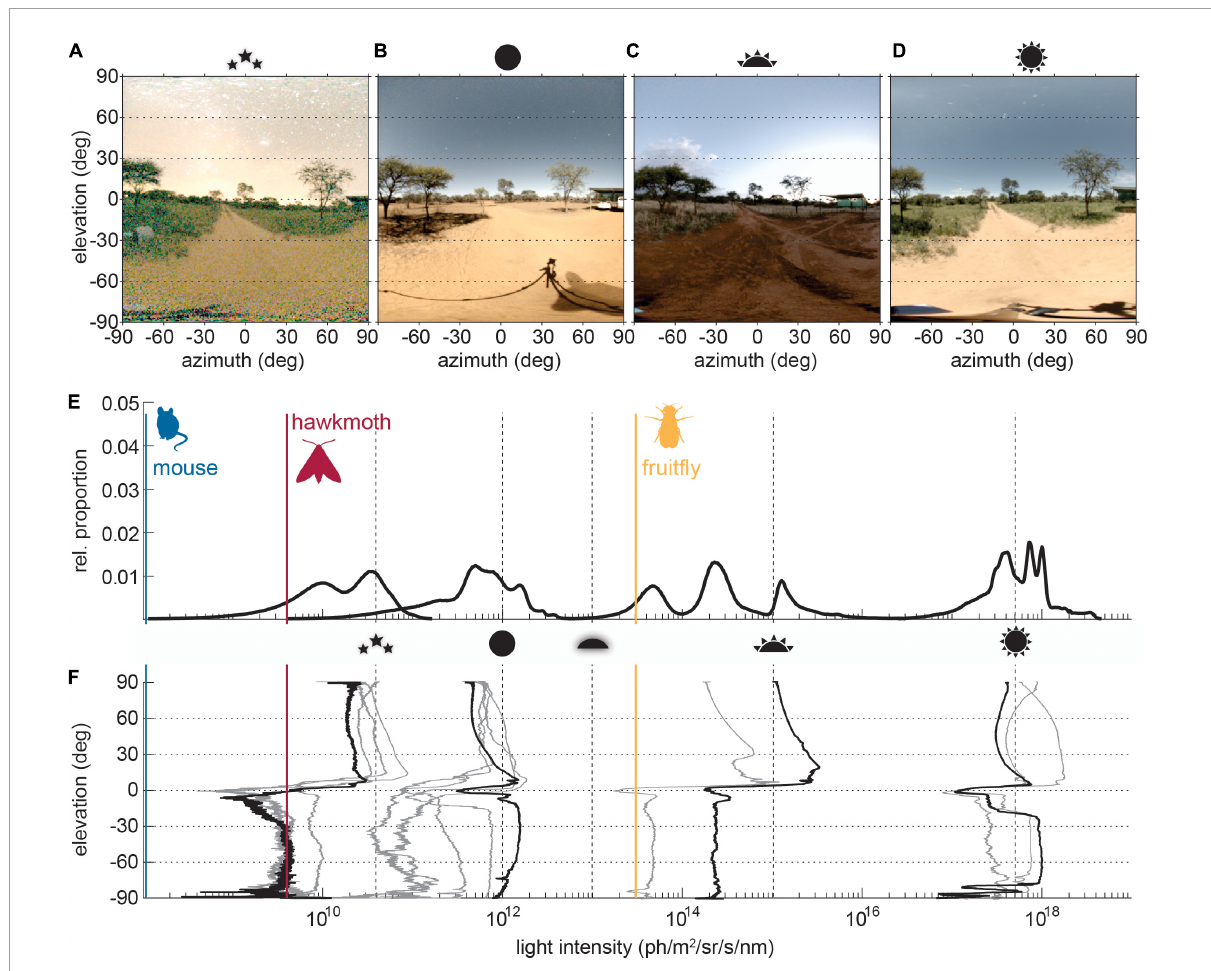
FIGURE1 Light intensity distributions in visual scenes across times of day. (A–D) The same visual scene near Vryburg (26 ◦ 23 (cid:48) 55.82 (cid:48)(cid:48) S, 24 ◦ 19 (cid:48) 37.380 (cid:48)(cid:48) E) in South Africa, photographed Southward under different celestial illumination conditions as indicated by the icons (starlight on a moonless night, full moon light with moon above 60 ◦ elevation, sunset, noon). (E) The relative proportion of pixel intensities and the (F) average pixel intensies across scene elevation. Panel (E) shows the average brightness histograms for starlight , moonlight , sunset/runrise , and sun at noon of a number of individual scenes with elevation intensity profiles depicted in gray in panel (F) . The profiles of the example scenes in panels (A–D) are highlighted in black. The dashed lines indicate average light intensities under typical celestial conditions ( max. starlight , max. moonlight , end of twilight , sunset/sunrise and max. sunlight ). The relative scaling of these were taken from Warrant (2008), while the scale was anchored in absolute terms to the intensity for sunlight from Nilsson and Smolka (2021). The visual thresholds of the three indicated model species [mouse Mus musculus (Umino et al., 2008), hawkmoth Deilephila elenor (Stöckl et al., 2016a), fruitfly Drosophila melanogaster (Currea et al., 2022)] were based on behavioral and physiological measurements of the response thresholds to moving contrast in optmotor-type tasks, both